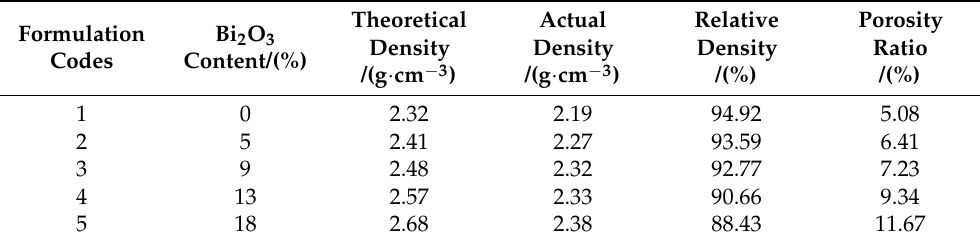
Table 2. Density data of PABs with different Bi 2 O 3 contents.